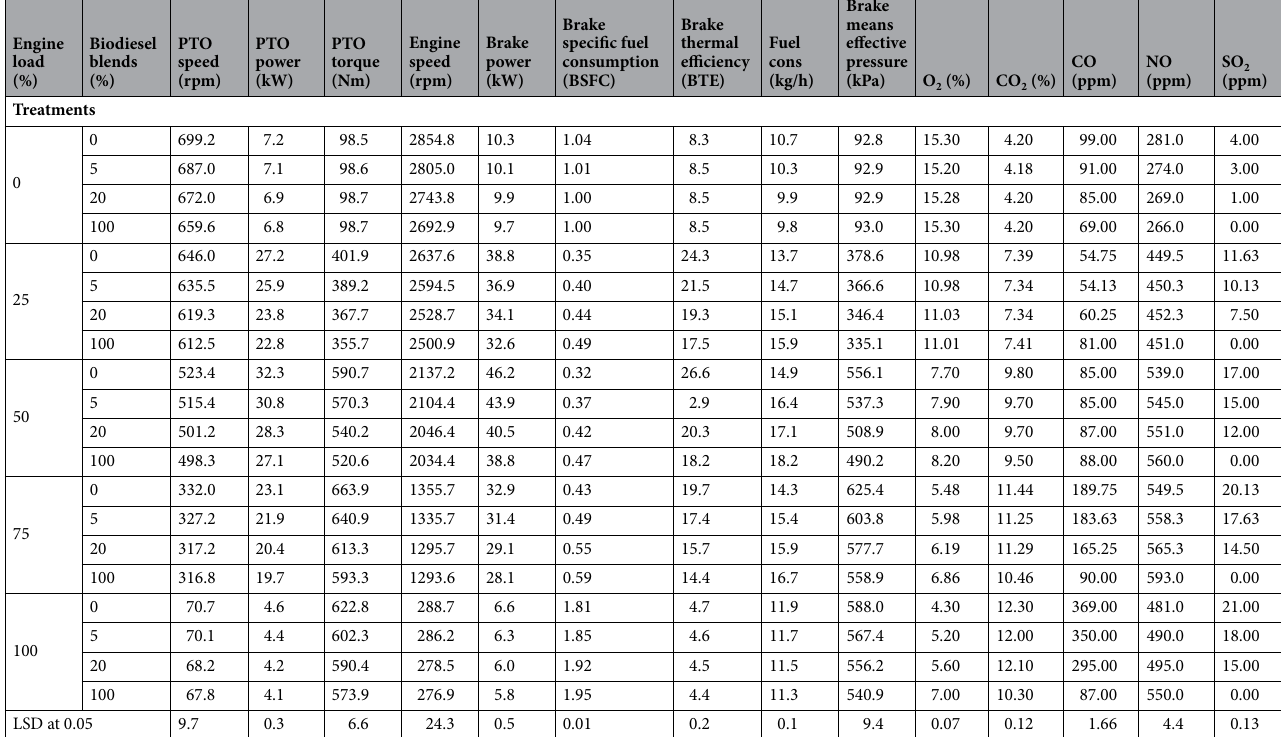
Table 2. Interaction effects between engine load percentage and fuel blends percentage on power take- off speed, power take-off power, power take-off torque, engine speed, brake power, brake specific